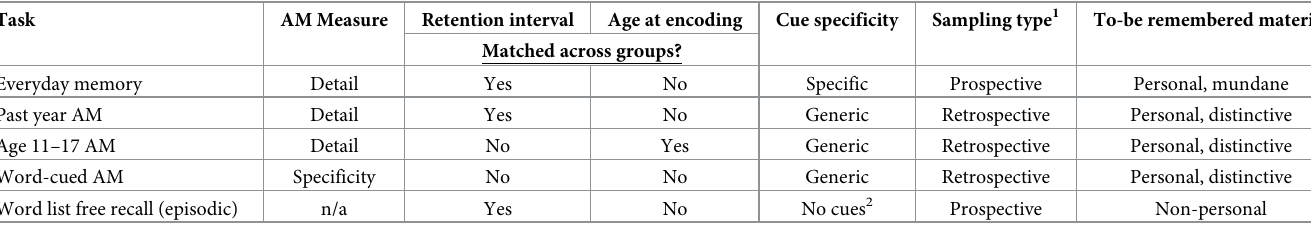
Table 3. Comparison of selected features of tasks used in the current